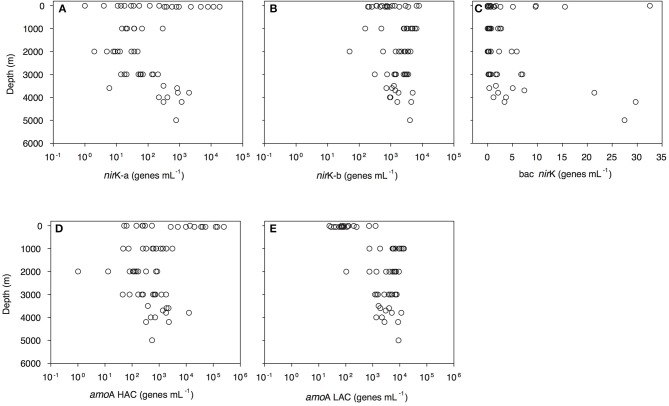
Depth profiles of functional gene abundances: archaeal nirK-a (A) and nirK-b (B) and bacterial nirK (C) archaeal HAC-amoA (D) and LAC-amoA (E) nitrification genes measured by q-PCR. amoA-HAC, “high-ammonia concentration” archaeal amoA; amoA-LAC, “low-ammonia concentration” archaeal amoA; nirK-a and nirK-b, archaeal nitrite reductase K type a and b; bac nirK, bacterial nitrite reductase K.